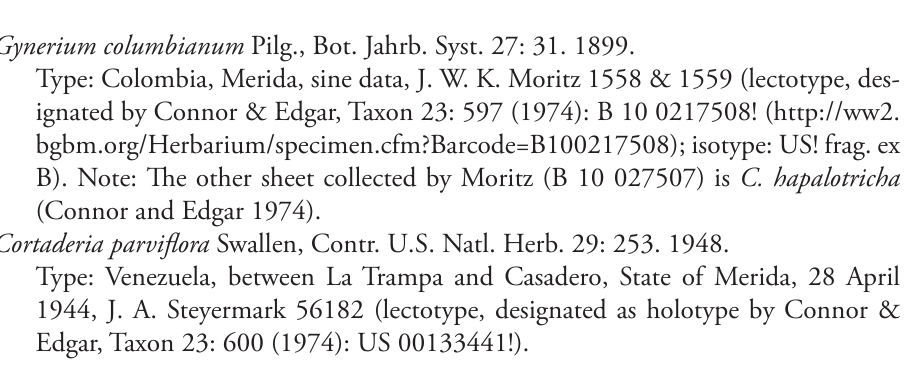
Fig. 1L Gynerium columbianum Pilg., Bot. Jahrb. Syst. 27: 31. 1899. Type: Colombia, Merida, sine data, J. W. K. Moritz 1558 & 1559 (lectotype, des- ignated by Connor & Edgar, Taxon 23: 597 (1974): B 10 0217508! (http://ww2. bgbm.org/Herbarium/specimen.cfm?Barcode=B100217508); isotype: US! frag. ex B). Note: The other sheet collected by Moritz (B 10 027507) is C. hapalotricha (Connor and Edgar